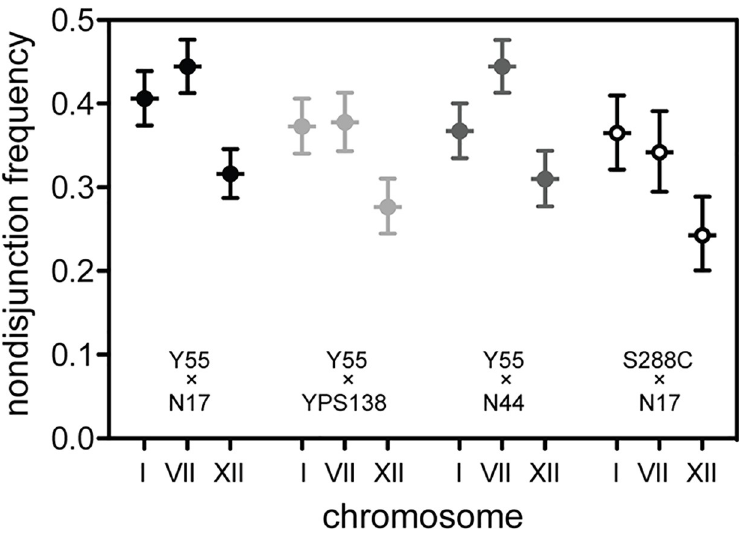
Fig 3. Chromosome XII shows reduced nondisjunction in interspecific hybrids. Chr XII exhibited a markedly lower nondisjunction rate than did other chromosomes in interspecific hybrids between S . cerevisiae strain Y55 and S . paradoxus strain N17 (data reproduced from Fig 2). We confirmed this result by examining the segregation of three chromosome pairs (I, VII, and XII) in crosses between S . cerevisiae strain Y55 and two other S . paradoxus strains from different clades: the American B strain YPS138 and the Far Eastern strain N44, as well as a cross between S . paradoxus strain N17 and a second S . cerevisiae strain, the laboratory model S288C. Underlying data can be found in S1 Data. Error bars represent binomial 95% confidence intervals calculated using JavaStat (http://statpages.info/confint.html). Chr,